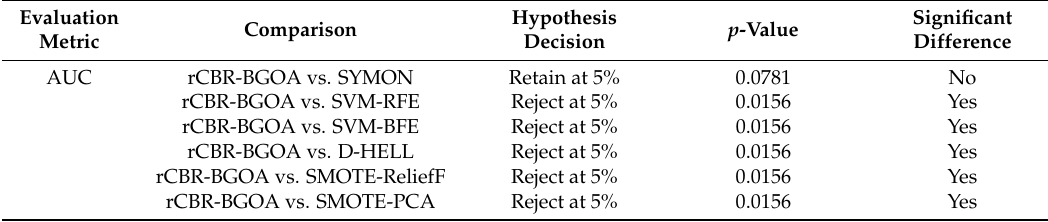
Table 7. Wilcoxon signed-rank test for AUC evaluation metric.